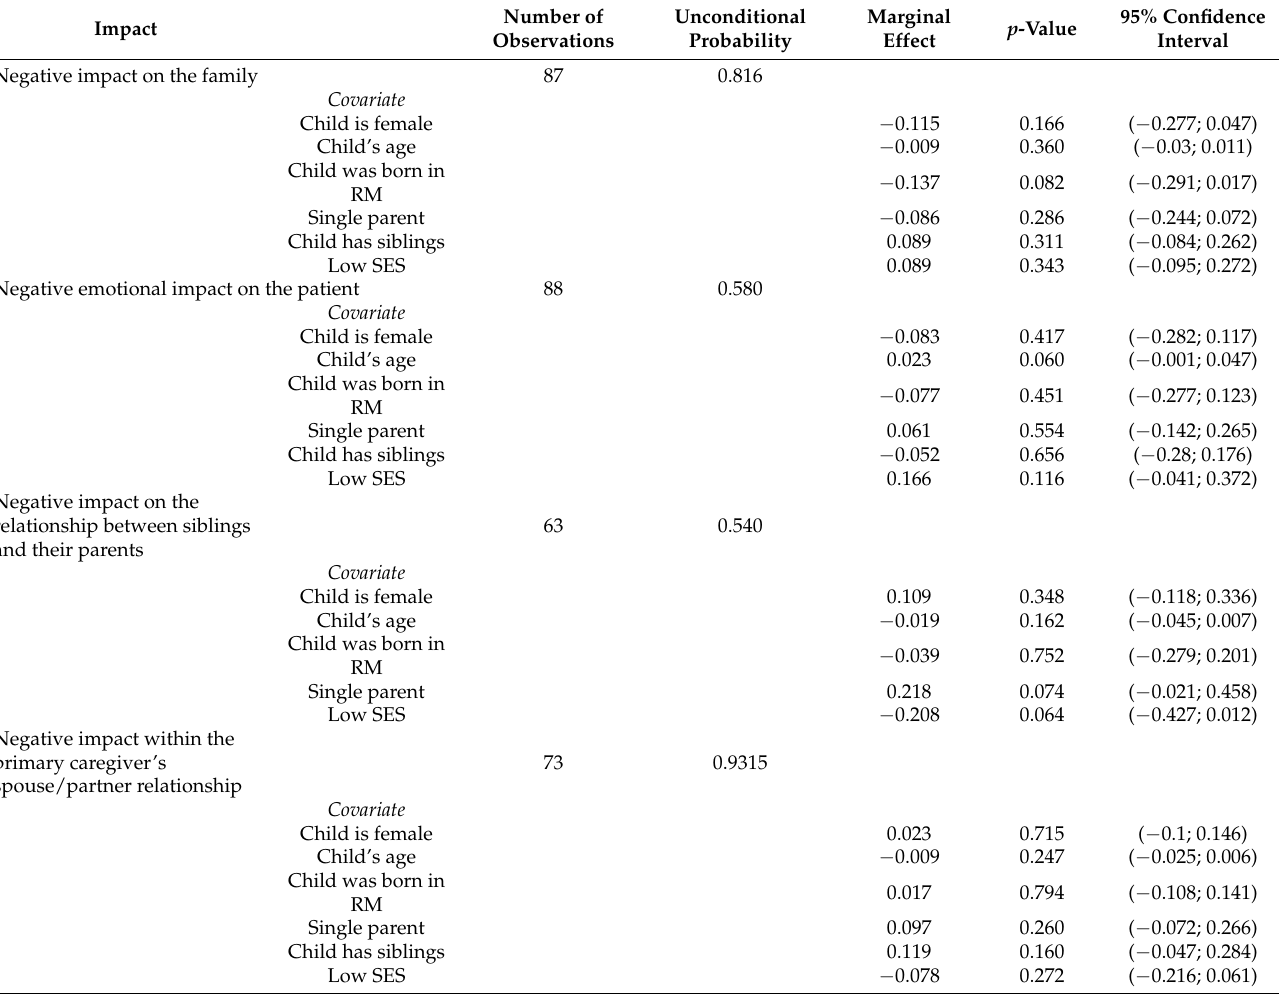
Table 6. Factors associated with selected impacts of the